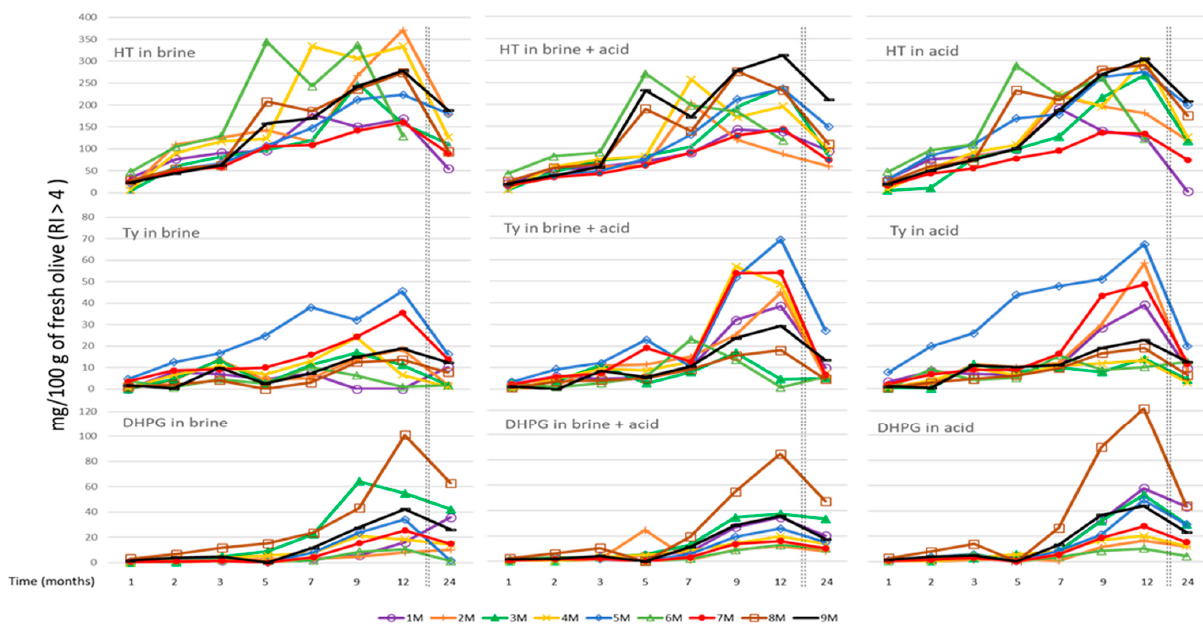
Figure 1. Solubilization of hydroxytyrosol (HT), tirosol (Ty) and 3,4-dihydroxyphenylglycol (DHPG) during 24 months in three different storage liquids (brine, brine in acid, and acid) for nine varieties of olives with a ripeness index higher than four.